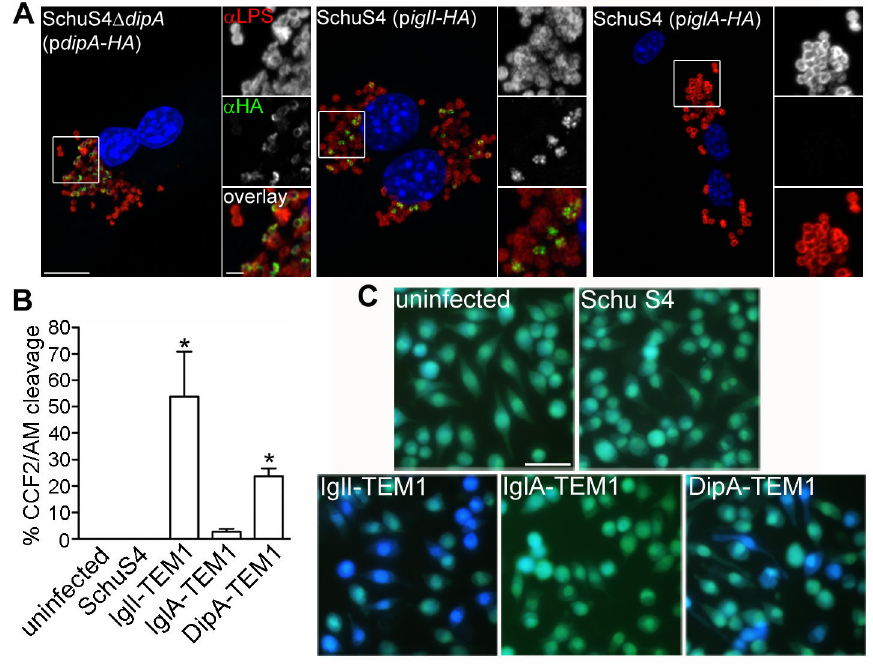
Figure 3. DipA is exposed to the host cytosol during macrophage infection. (A) Representative confocal micrographs of BMMs infected for 10 h with SchuS4Δ dipA (p dipA-HA ), SchuS4(p iglI-HA ), or SchuS4(p iglA-HA ). Using conditions that permeabilize host plasma membranes but not bacterial membranes (described in Materials and Methods), samples were processed for immunofluorescence labelling of HA-tagged proteins (green) and bacterial LPS (red), and counterstained with DAPI to label DNA (blue). Magnified insets show single channel images of the boxed area. Scale bars, 10 or 2 µm. (B) Quantification of CCF2/AM cleavage in J774A.1 cells that were either uninfected or infected with SchuS4, or SchuS4 expressing C-terminal TEM1 fusions with IglI, IglA or DipA. After 16 h, infected macrophages were loaded with CCF2/AM and analyzed by live cell microscopy for blue fluorescence emission. At least 100 cells were scored per experiment. Data are means ± SD from a representative experiment performed in triplicate out of three independent repeats. Asterisks indicate statistically significant differences compared to uninfected, SchuS4-infected, and SchuS4 expressing IglA-TEM1-infected controls (* P < 0.05 , 1-way ANOVA, Tukey’s post-test). (C) Representative fluorescence micrographs of J774A.1 cells that were either uninfected or infected for 16 h with SchuS4, SchuS4 expressing IglI-TEM1, SchuS4 expressing IglA-TEM1, and SchuS4 expressing DipA-TEM1. Cells emitting blue fluorescence indicate delivery of TEM1 β-lactamase fusions to the cytosol and CCF2/AM cleavage. Intact CCF2/AM, indicating the absence of TEM1 β-lactamase activity in the cytosol, results in green fluorescence emission. Scale bar, 50